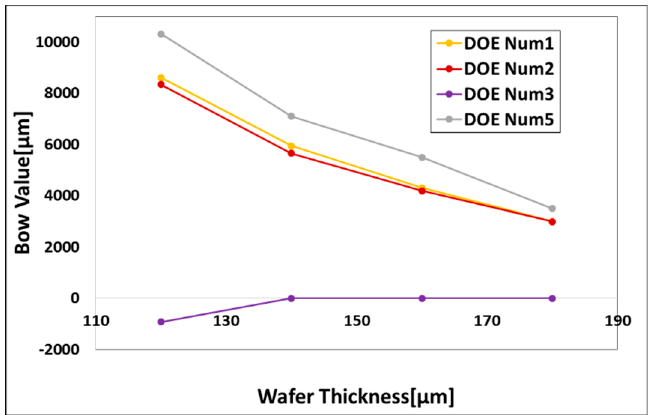
Figure 9. Results of bow experiments 1, 2, 3, and 5.